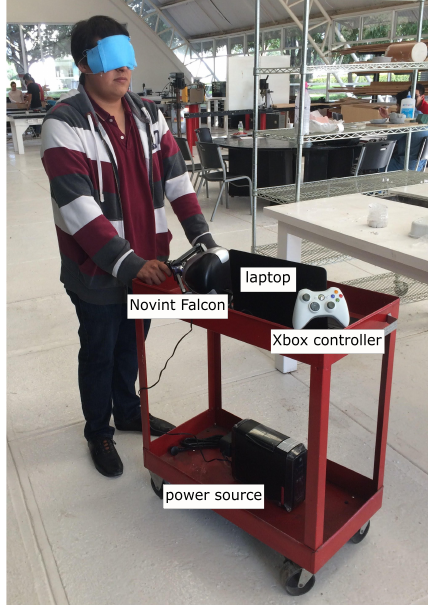
Figure 10. The blindfolded subject and the experimental setup used in the navigation